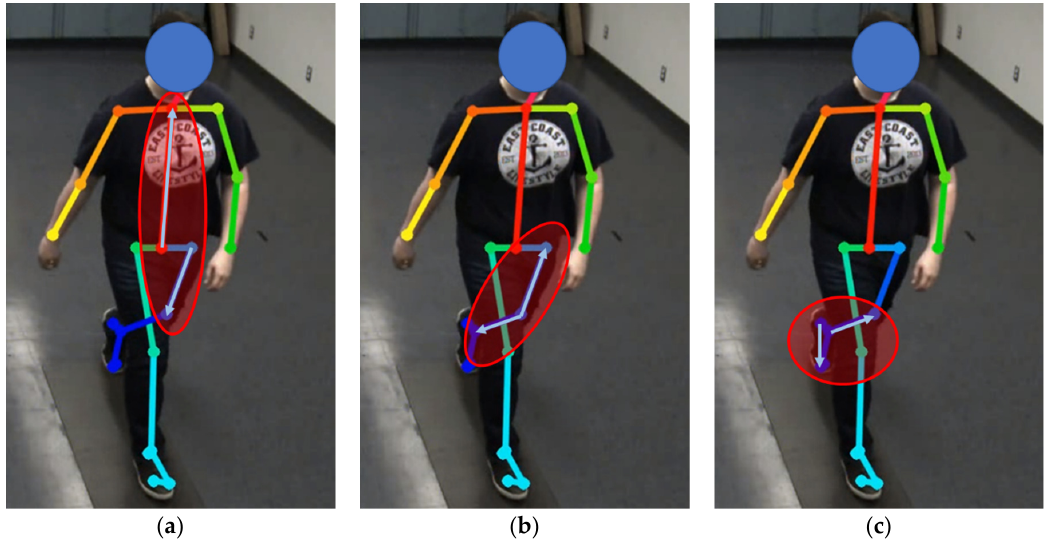
Figure 6. Leg angles measured during full strides. ( a ) hip angle, ( b ) knee angle, ( c ) ankle angle. Figure 7 shows the final software pipeline of the Smart Hallway.